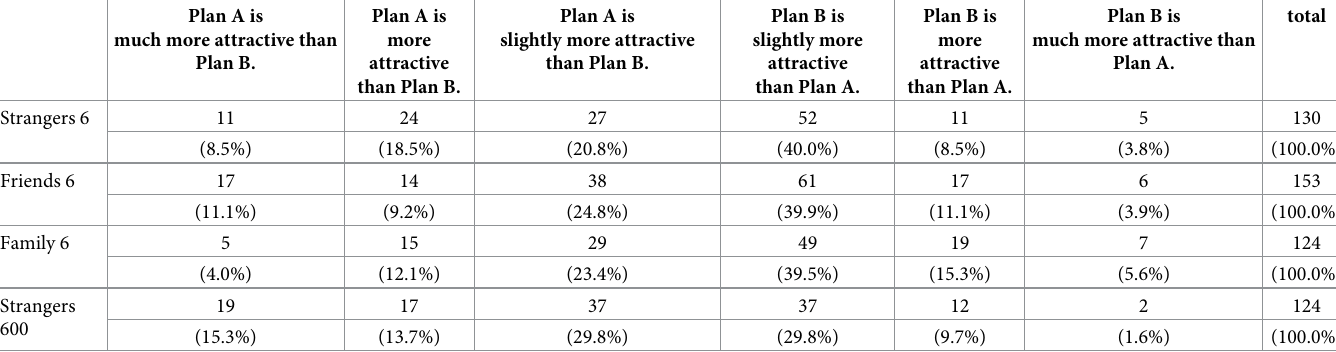
Table 4. Frequencies and percentages of choice in the Life-Death problem across 4 categories (negative frame). Plan A is much more attractive than